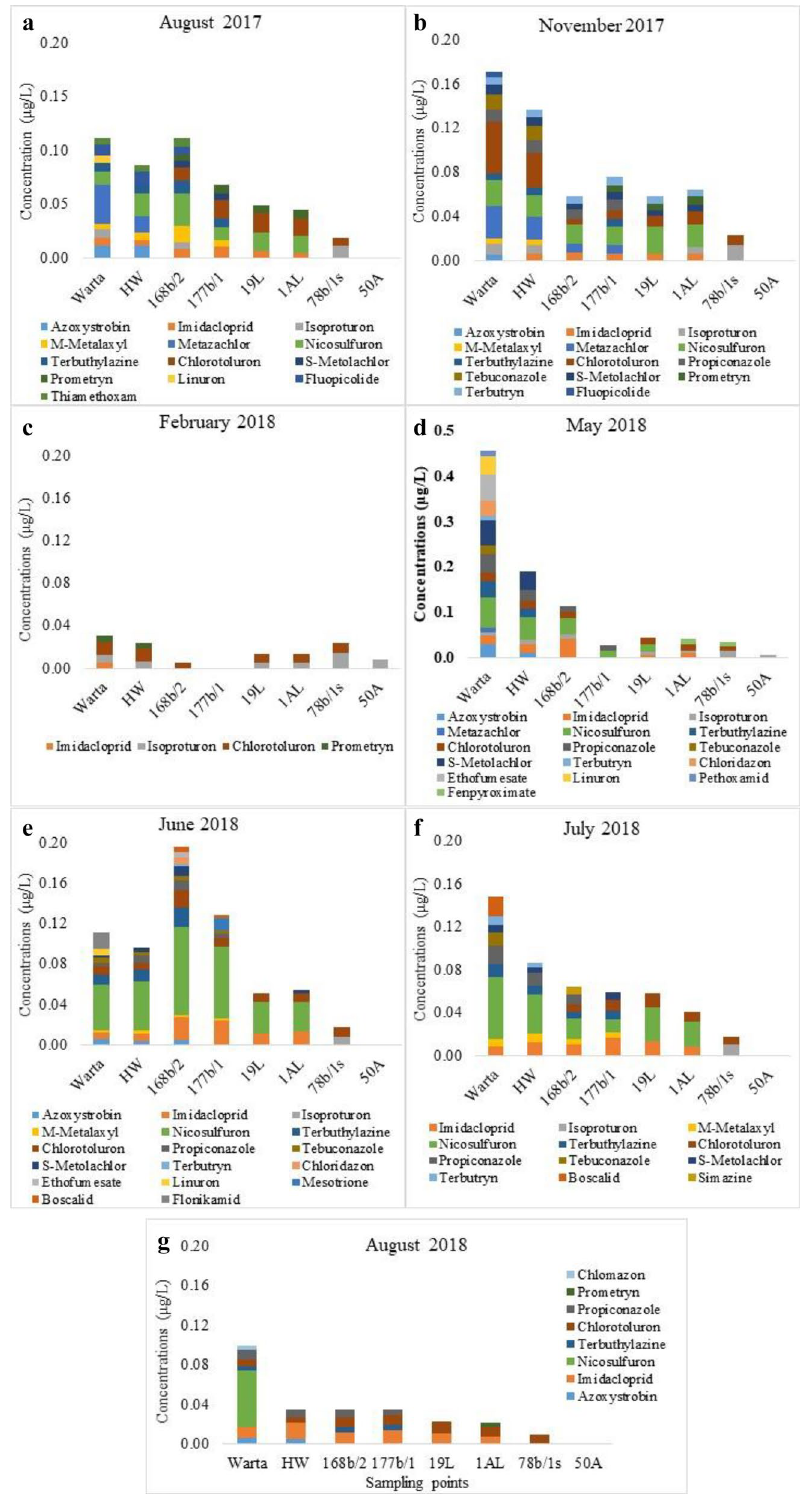
Figure 4. Total concentrations of pesticides at each sampling point divided into individual compounds in ( a ) August 2017, ( b ) November 2017, ( c ) February 2018, ( d ) May 2018, ( e ) June 2018, ( f ) July 2018, and ( g ) August